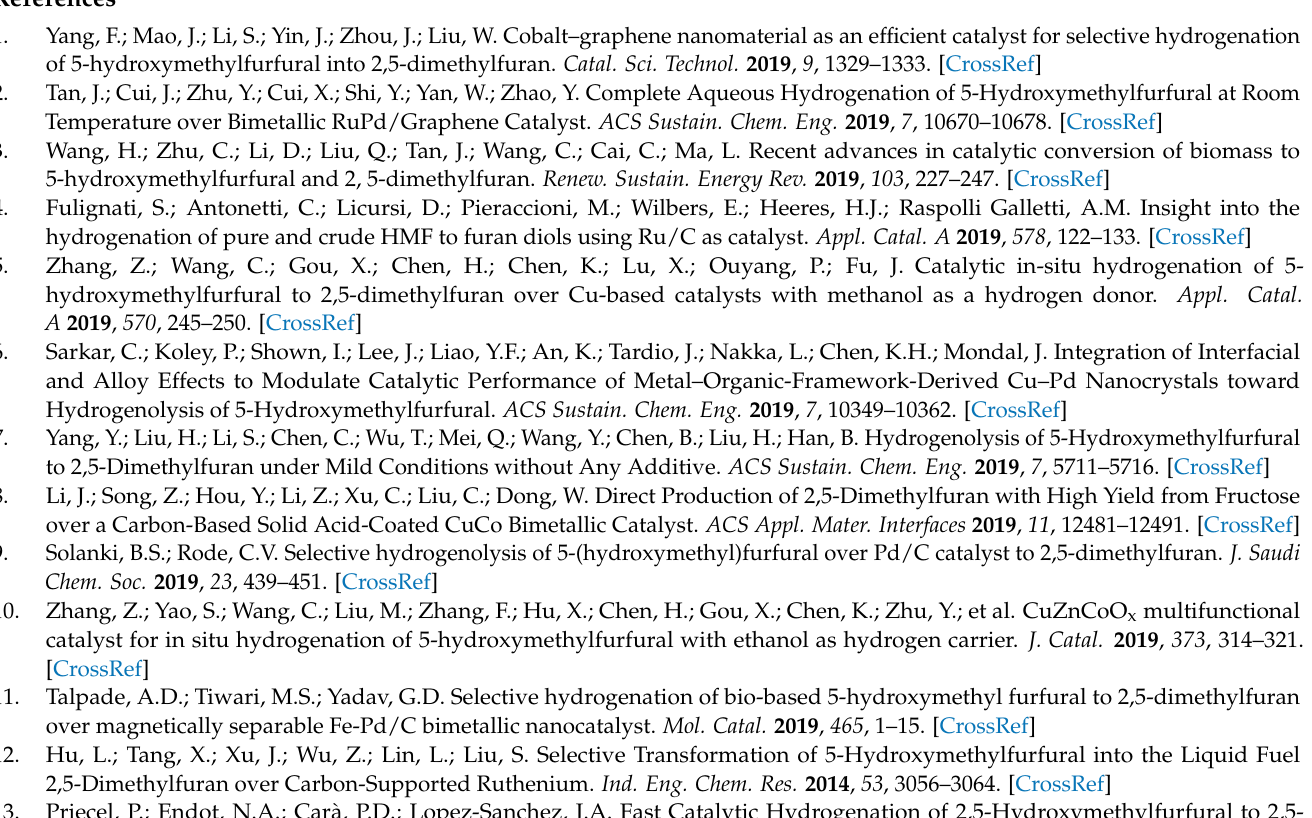
(g,h), Figure S2: The O 1s XPS spectra of different catalysts, Figure S3: The C 1s XPS spectra of different catalysts, Table S1: The O 1s and C 1s XPS peak fitting data of different catalysts, Table S2: Reports on the hydrogenation of HMF to DMF over Pt based catalysts, Figure S4: Effect of H 2 pressure on HMF hydrogenolysis over 0.5% Pt-2% FeO x /AC, Figure S5: The Fe 2p (a), Pt 4f (b), O